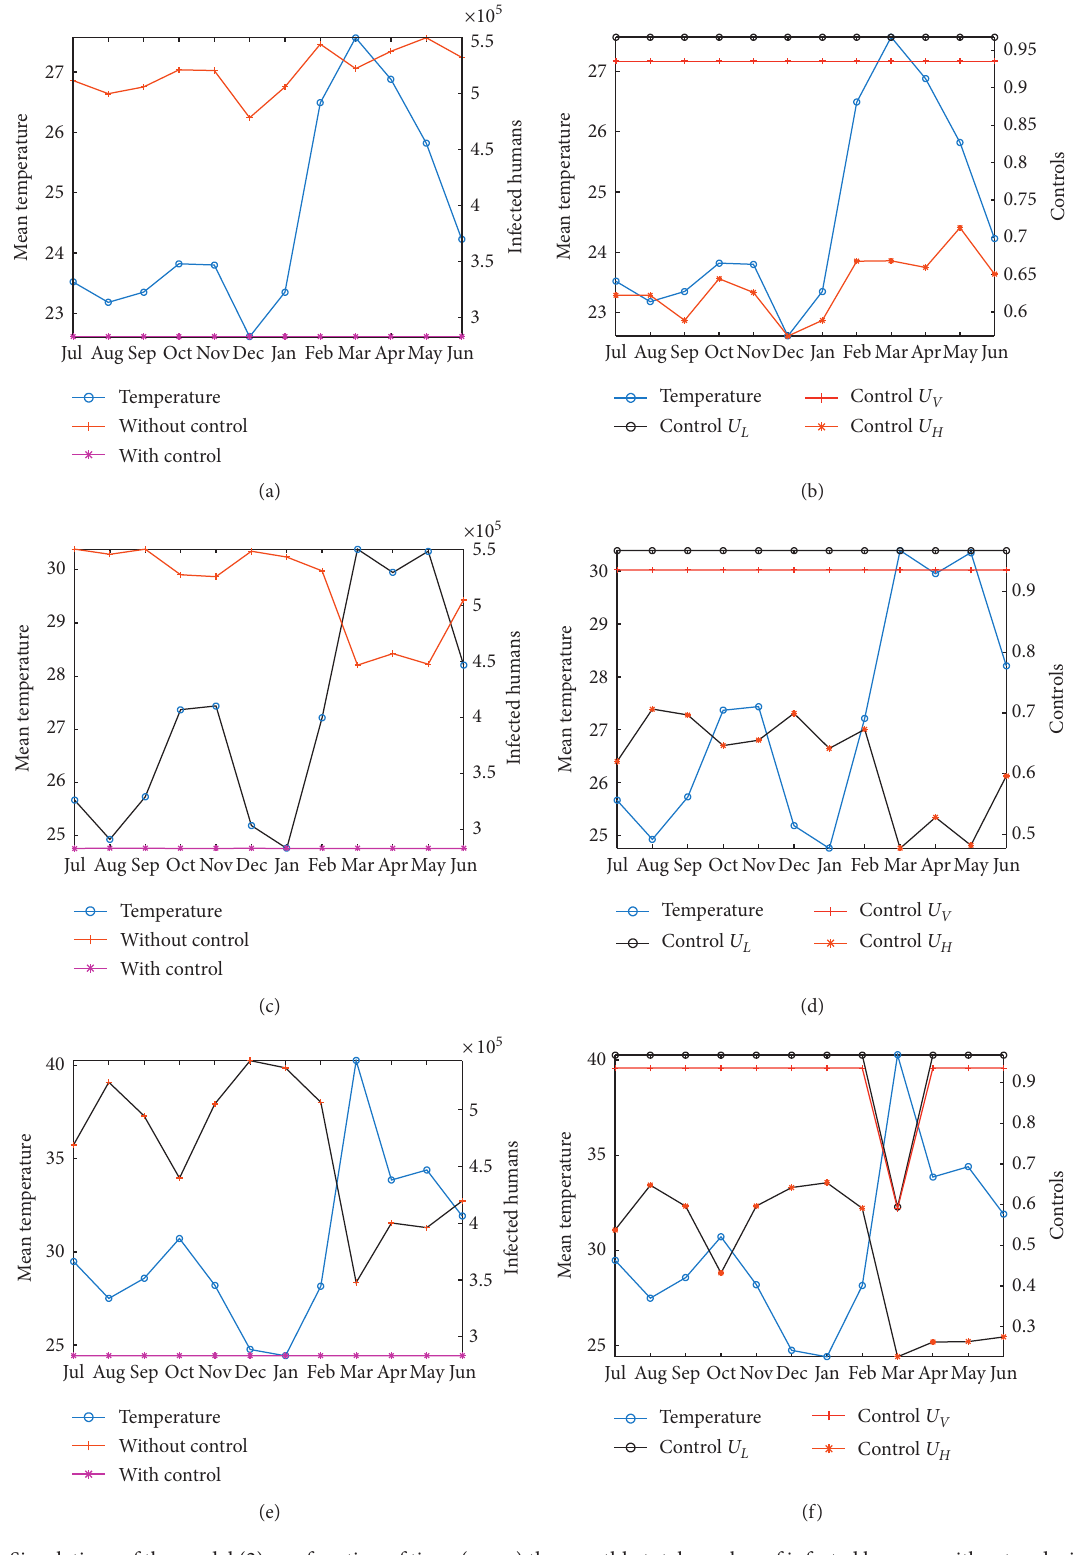
Figure 5: Simulations of the model (2) as a function of time: (a, c, e) the monthly total number of infected humans without and with control and (b, d, f) optimal controls u H ( t ) ,u L ( t ) , and u V ( t ) , in NZerekore, Guinea; Bamako, Mali; and Niamey, Niger; in West Africa. The mean monthly temperature is plotted in blue lines and is superimposed onto each